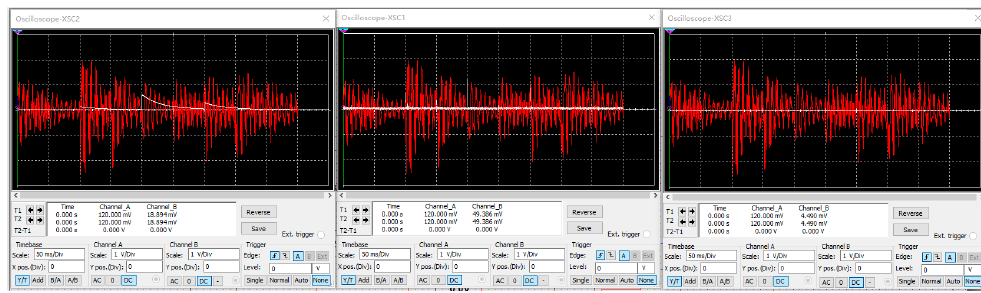
Figure 8. Change process of corncobs signal.